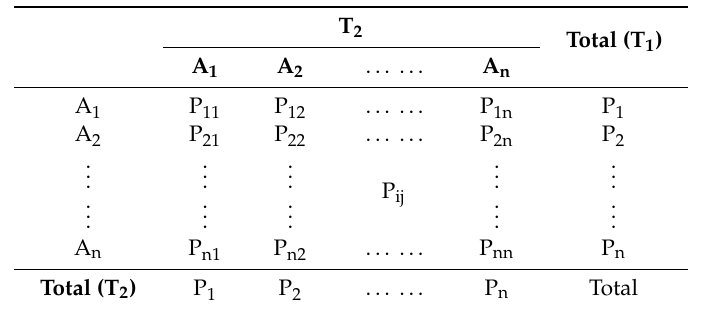
Table 1. Land transfer